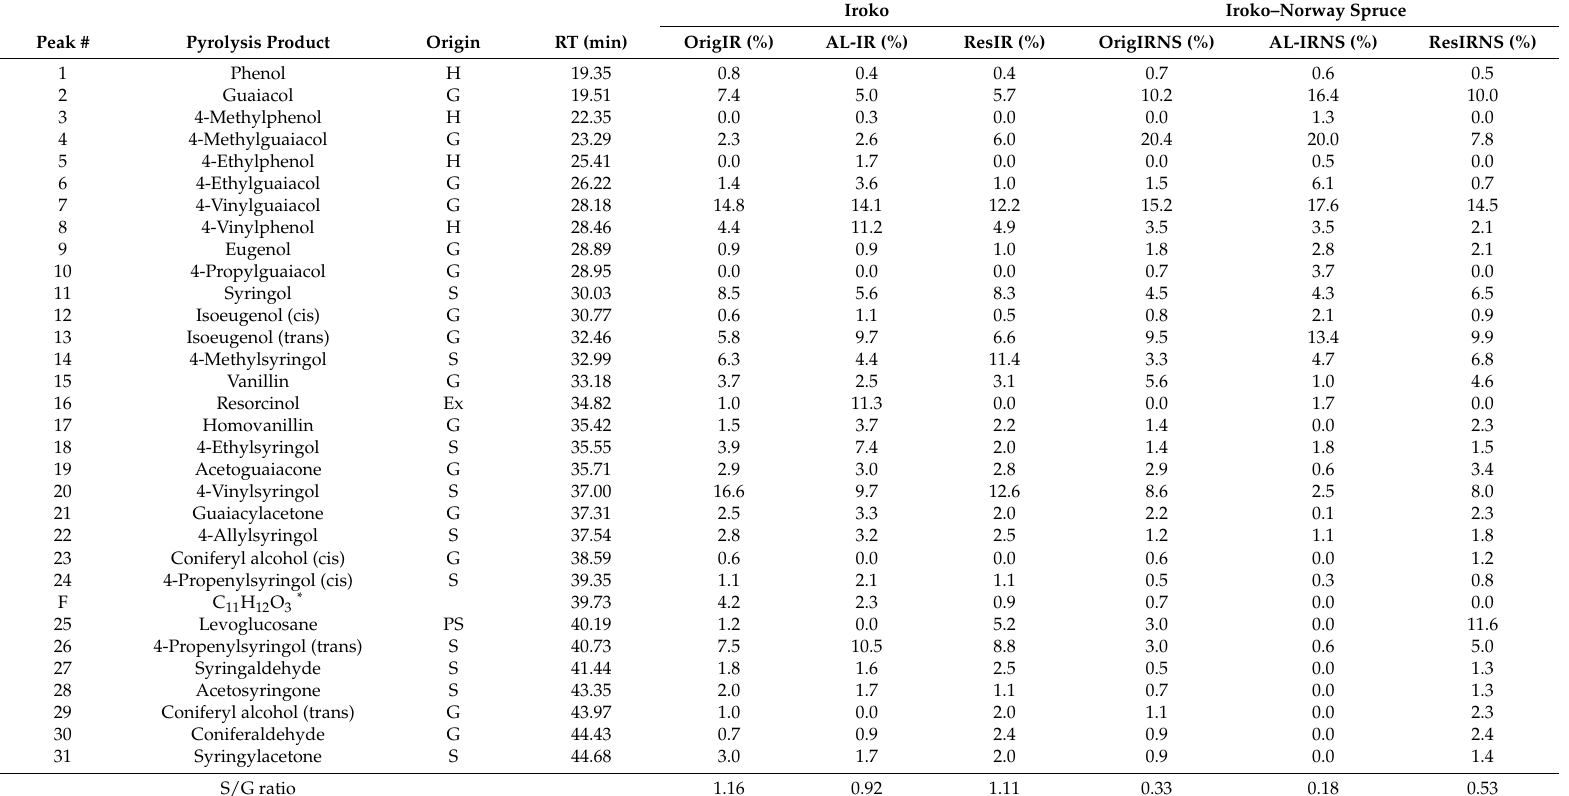
Table 2. Retention times, relative abundances, assignment of pyrolysis products to guaiacyl-type (G), syringyl-type (S) and p -coumaryl/hydroxyphenyl (H) units and respective S/G ratios in original Iroko sawdust (OrigIR), original mixed sawdust of Iroko–Norway spruce (OrigIRNS), respective isolated Acidolysis lignin fractions (AL-IR, AL-IRNS) and acidolysis residues (ResIR, ResIRNS). PS indicates polysaccharides origin, EX indicates extractives origin. * compounds no. 65 and 66 in Faix et al.